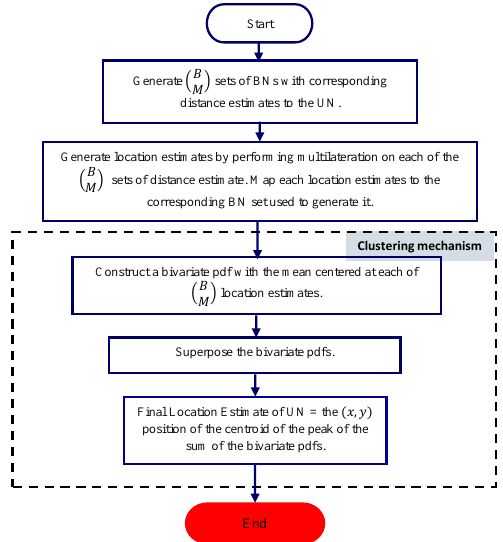
Figure 5. Majority Rule-based localization scheme